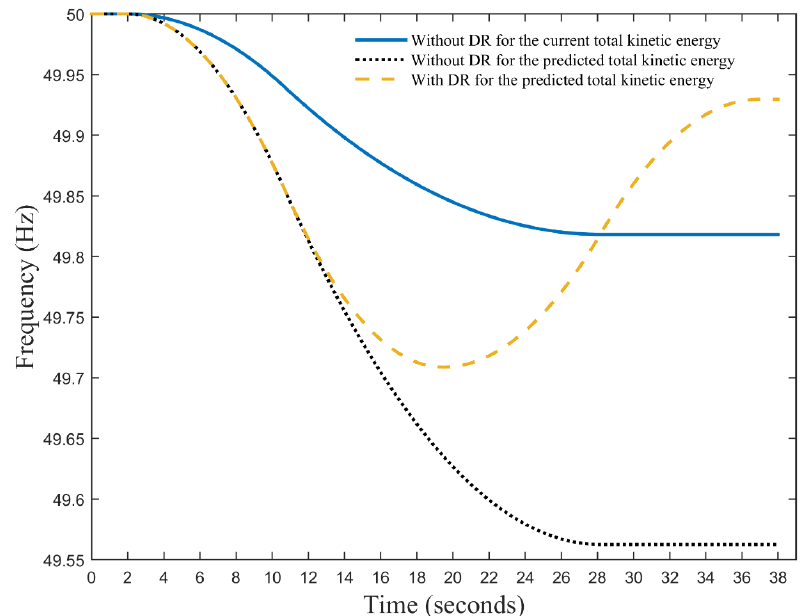
Figure 6. System frequency (i.e., a 1.32 GW generation loss) without and with the dynamic controller, considering 1.05 GW power reserve of frequency-controlled DHPs in all DNO regions.